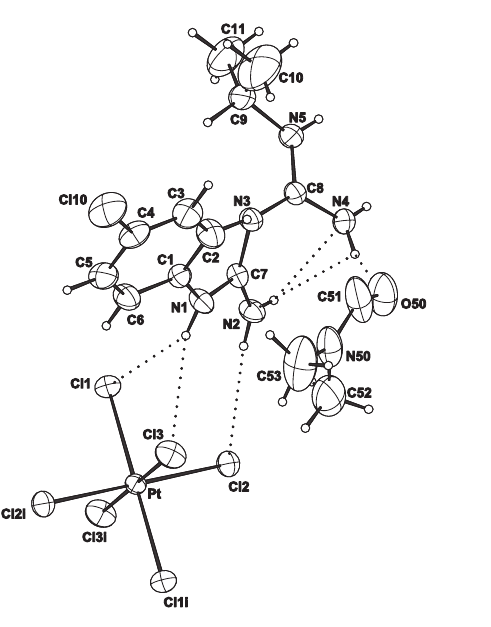
Table 4. Data collection and handling.